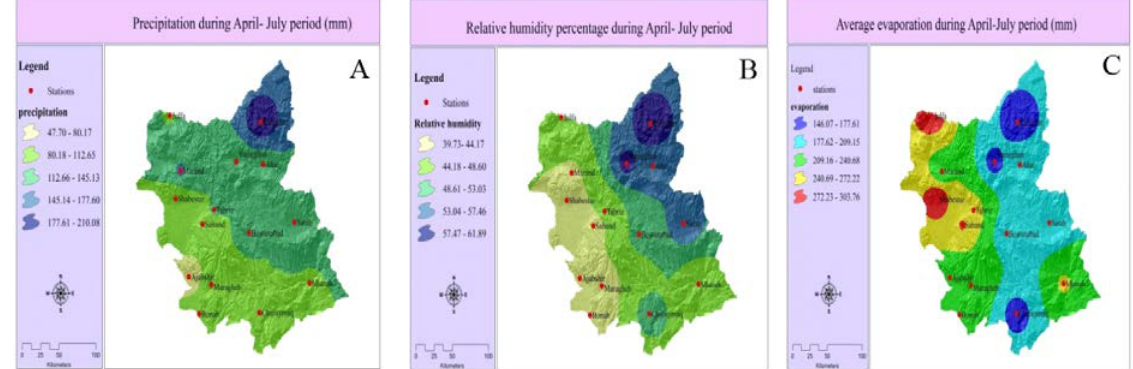
Fig. 3: Map of hydrological parameters during April-July: A) Map of precipitation B) Map of relative humidity percentage C): Map of average